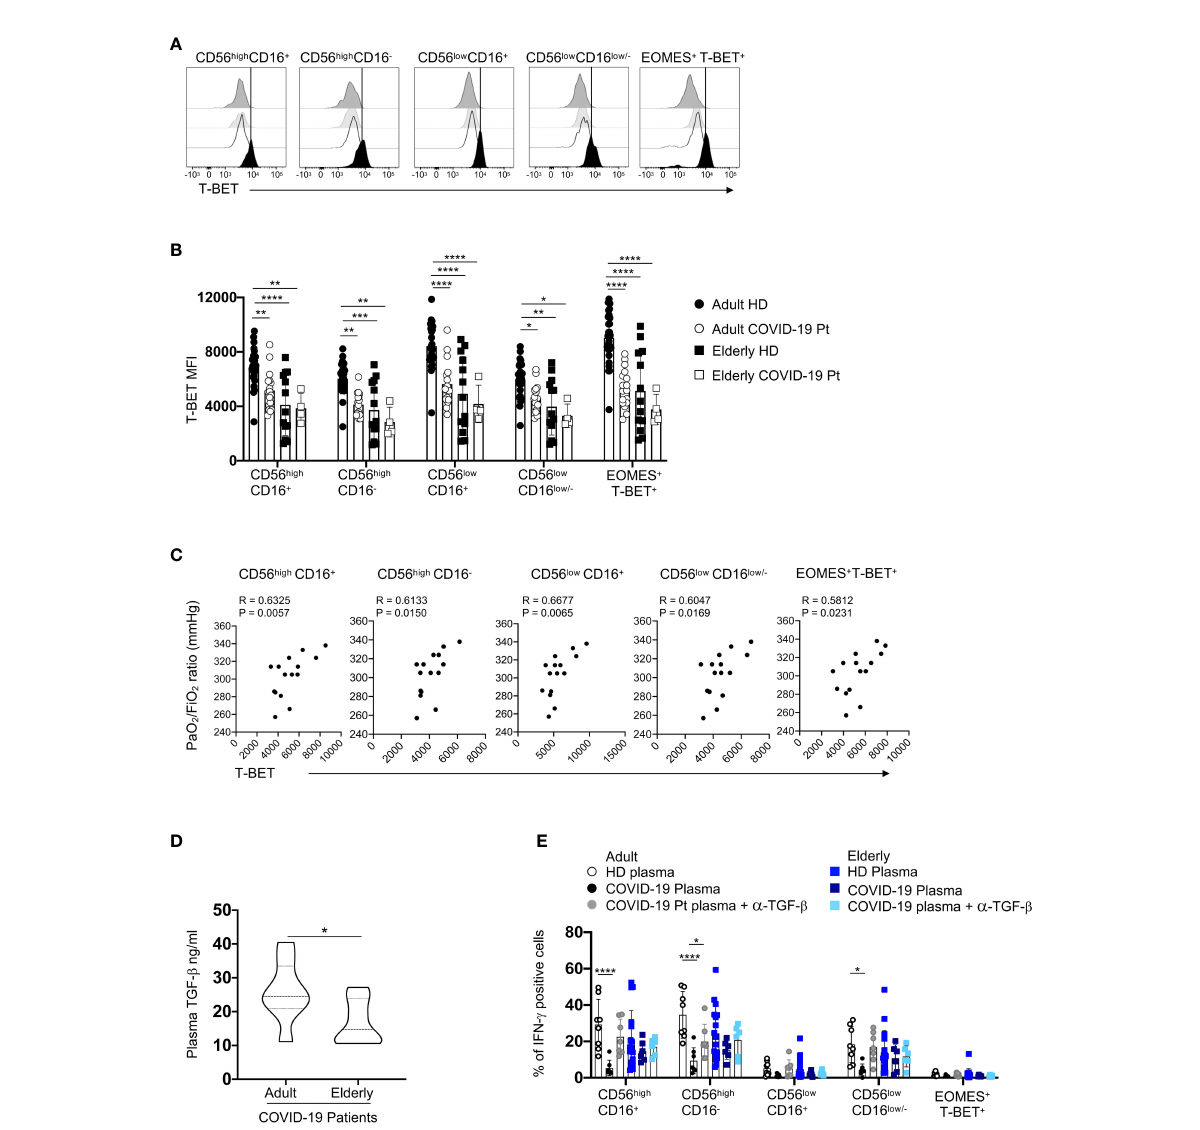
FIGURE 10 TGF- b regulates IFN- g production in adult COVID-19 NK cell subsets. Representative overlays displaying T-BET expression of distinct NK cell subsets from adult and elderly COVID-19 patients and age-matched controls (A) . Summary of data showing the median values ± SD of T-BET MFI expression on each subset (B) . Spearman ’ s rank correlation of T-BET expression (MFI) and the oxygenation index PaO2/FiO2 ratio at hospital admission in adult patients (C) . Plasma levels of TGF- b of elderly and adult COVID-19 patients at hospital admission (adult = 12, elderly = 7). * p< 0.05 unpaired t-student test analysis is indicated (D) . PBMC from healthy donors were cultured in medium containing adult healthy or COVID-19 plasma or elderly healthy or COVID-19 plasma for 48h in the absence or in the presence of a -TGF- b blocking antibody. The percentage of IFN- g positive cells after IL-12 plus IL-18 stimulation was assessed for each NK cell subset. Histograms represent the mean ± SD (E) . * p< 0.05, ** p< 0.01, *** p< 0.001, **** p< 0.0001. Two-way analysis of variance (ANOVA) Tukey ’ s multiple comparisons test and One way ANOVA Kruskal-Wallies test multiple